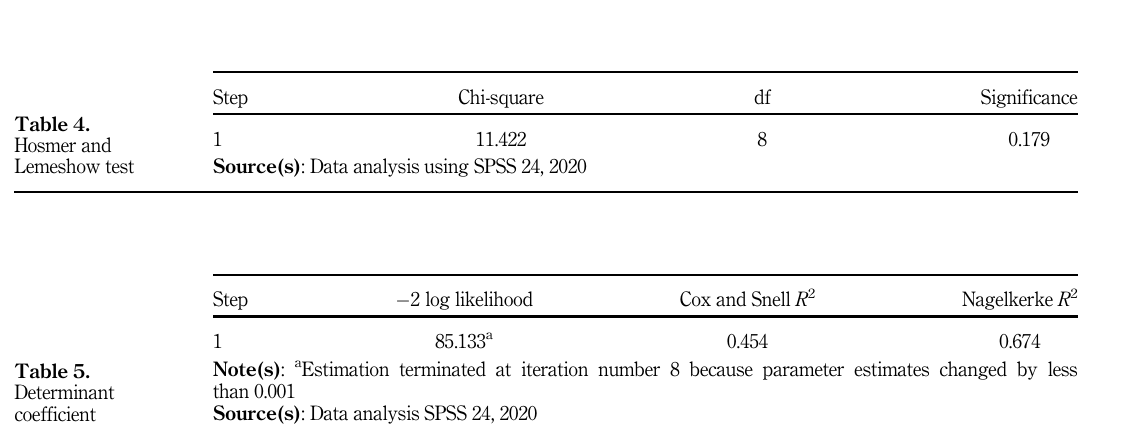
Table 3. Overall model fit test